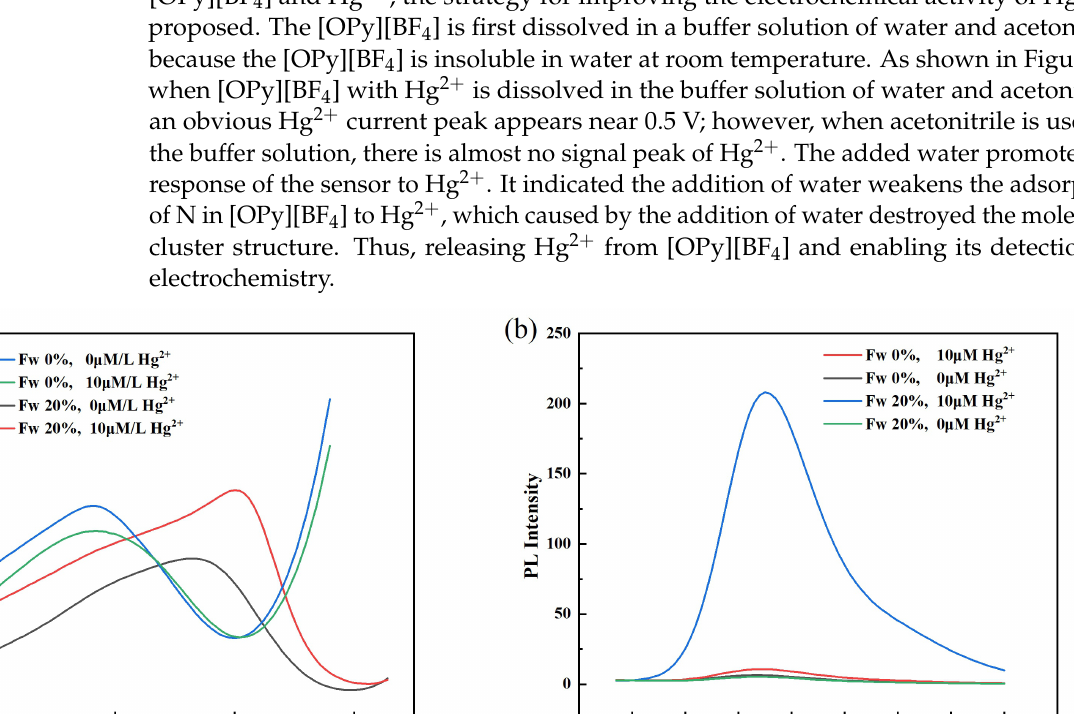
: V H + V ACN 2 O 2 O